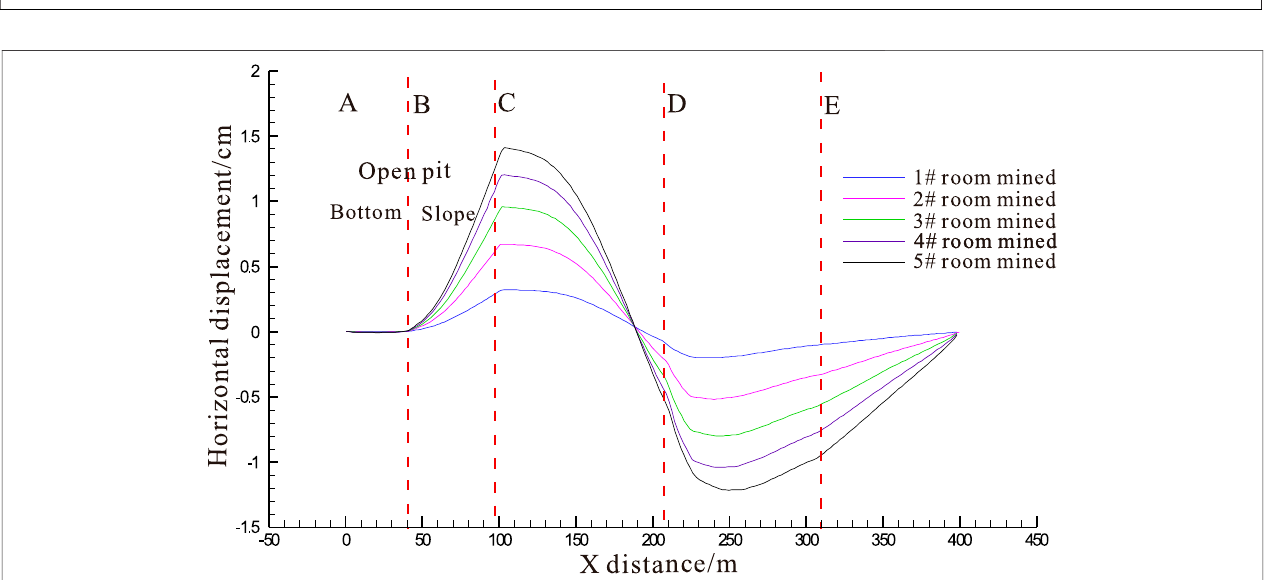
FIGURE 14 | Horizontal displacement curves of the surface when mining Rooms 1# to 5#.